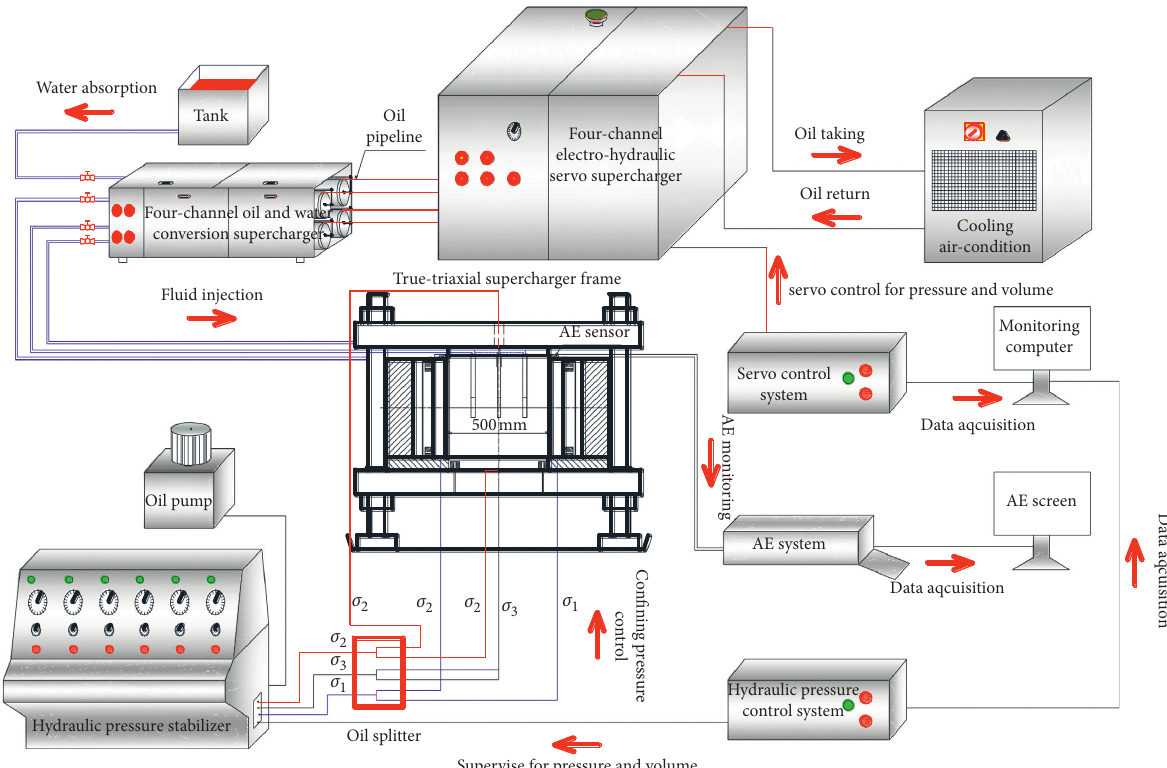
Figure 2: Experimental system for true triaxial hydraulic fracturing [23].